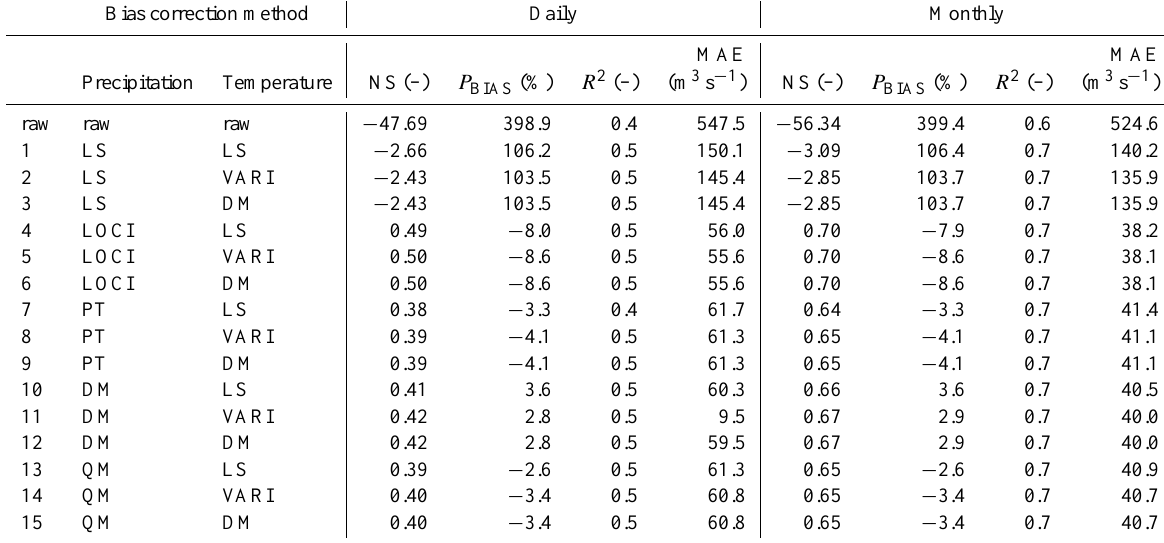
Table 3. Performances of simulated streamflows driven by raw RCM-simulated data (raw) and 15 combinations of bias-corrected precipi- tation and temperature data (denoted as numbers from 1 to 15) compared to the simulation driven by observed climate (default) during the period 1986 ∼ 2001. For simulations 1–15, solar radiation is corrected with the LS